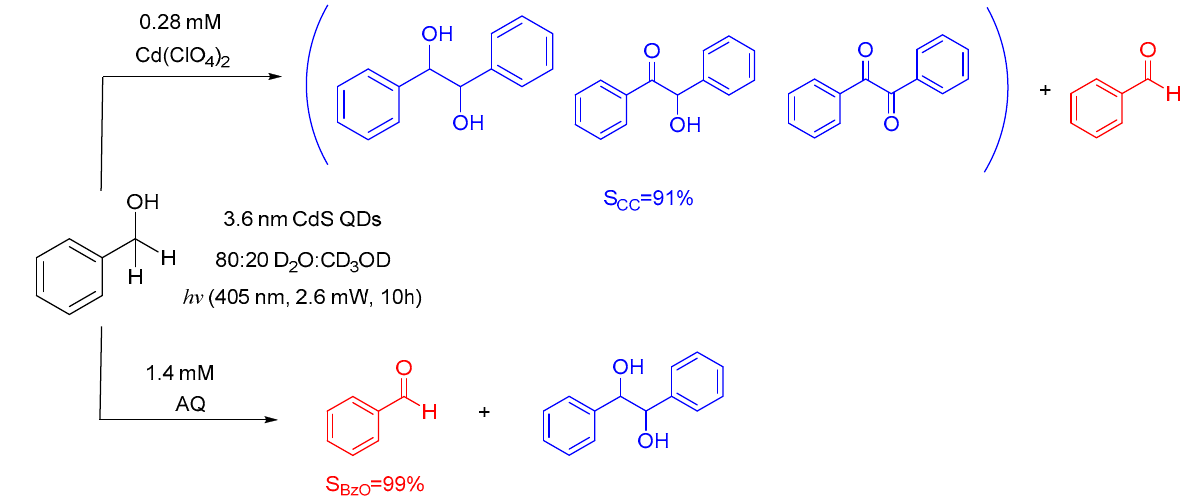
Scheme 3. Selectivities achieved for either C–C coupling or oxidation of benzyl alcohol catalyzed by CdS quantum dots (QDs).